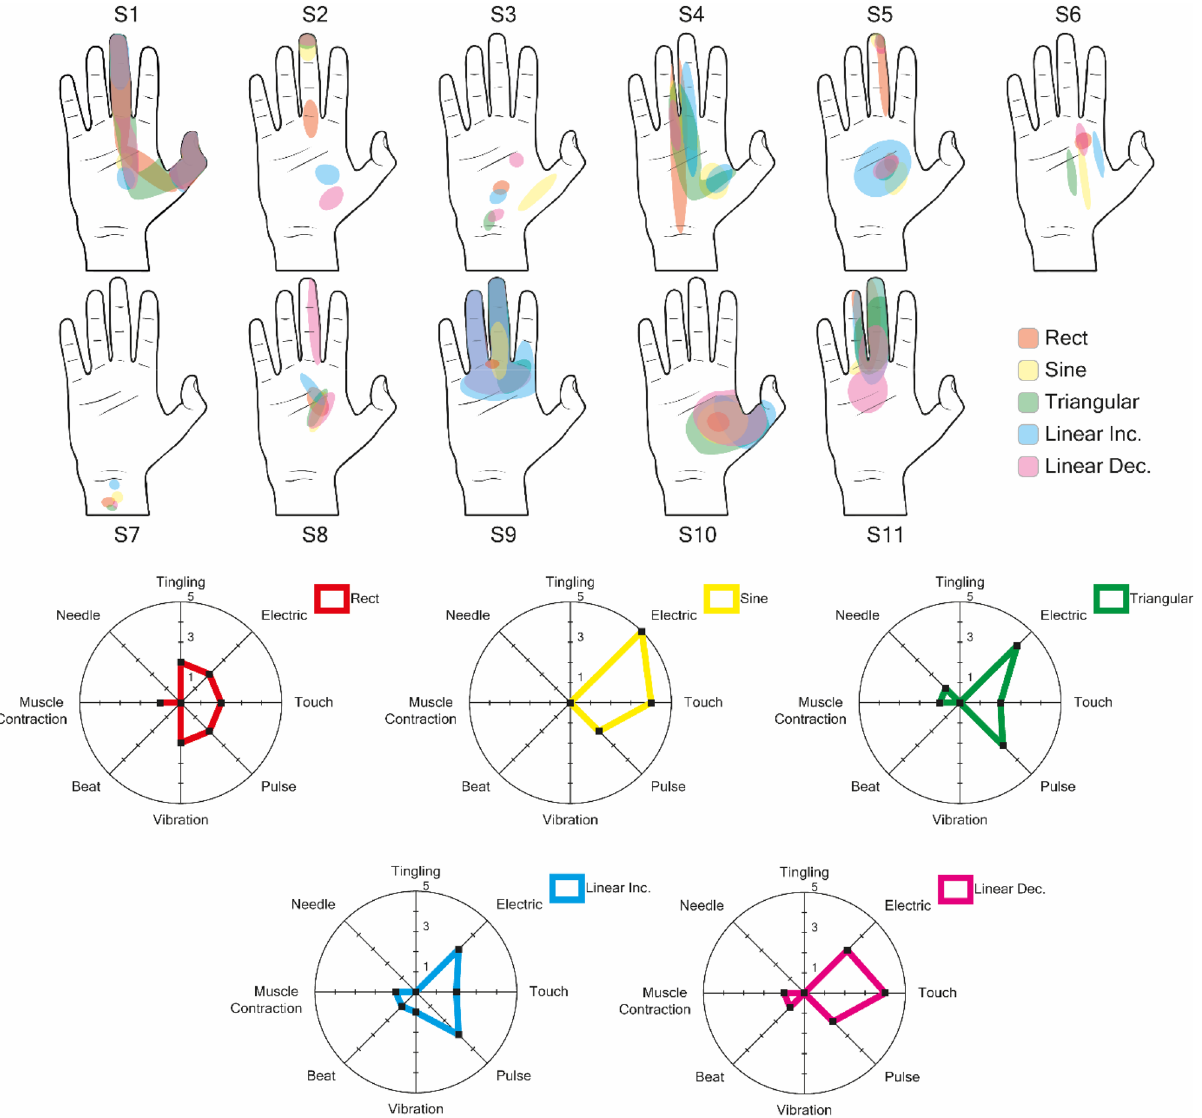
Figure 3. The sensations reported following single-pulse stimulation were reported and superimposed on the same drawing. Although in some cases the sensations share the same point of origin, it can be seen that as the type of waveform varies, the sensation area expands or moves, a phenomenon that could indicate a different activated neural portion or a greater number of fibers recruited. In addition, the sensations reported by the eleven volunteers were collected and graphed with respect to the type of waveform, showing how each waveform has different trends in terms of the type of sensation. Radar plots have been graphed inside the range of the sensation with the maximum correspondences. In particular, it appears that waveforms with greater peak amplitude were more likely to arouse electrical